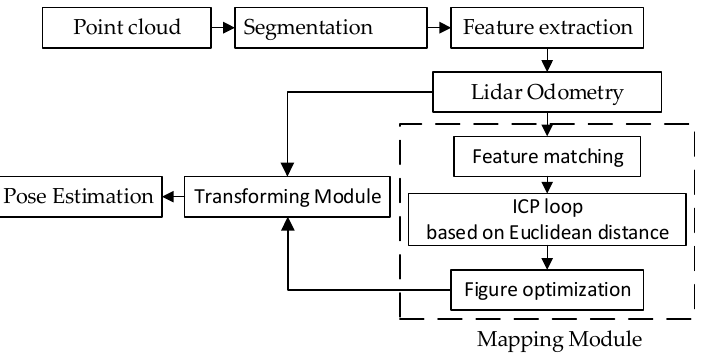
Figure 1. System structure diagram of the LeGO-LOAM algorithm.